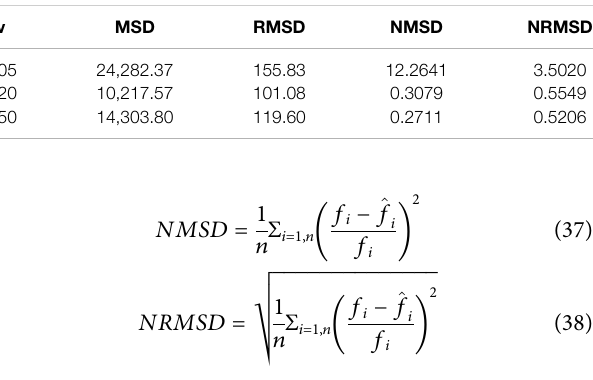
TABLE6| Consideredvaluesoftheindependentvariablesintheapplicationtothe network of